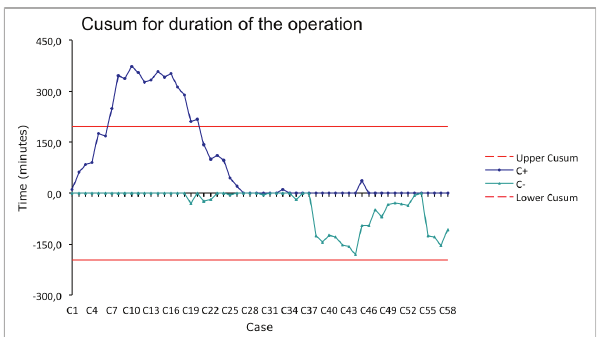
Graph 2: CUSUM chart for length of hospital stay. Consistency could not be